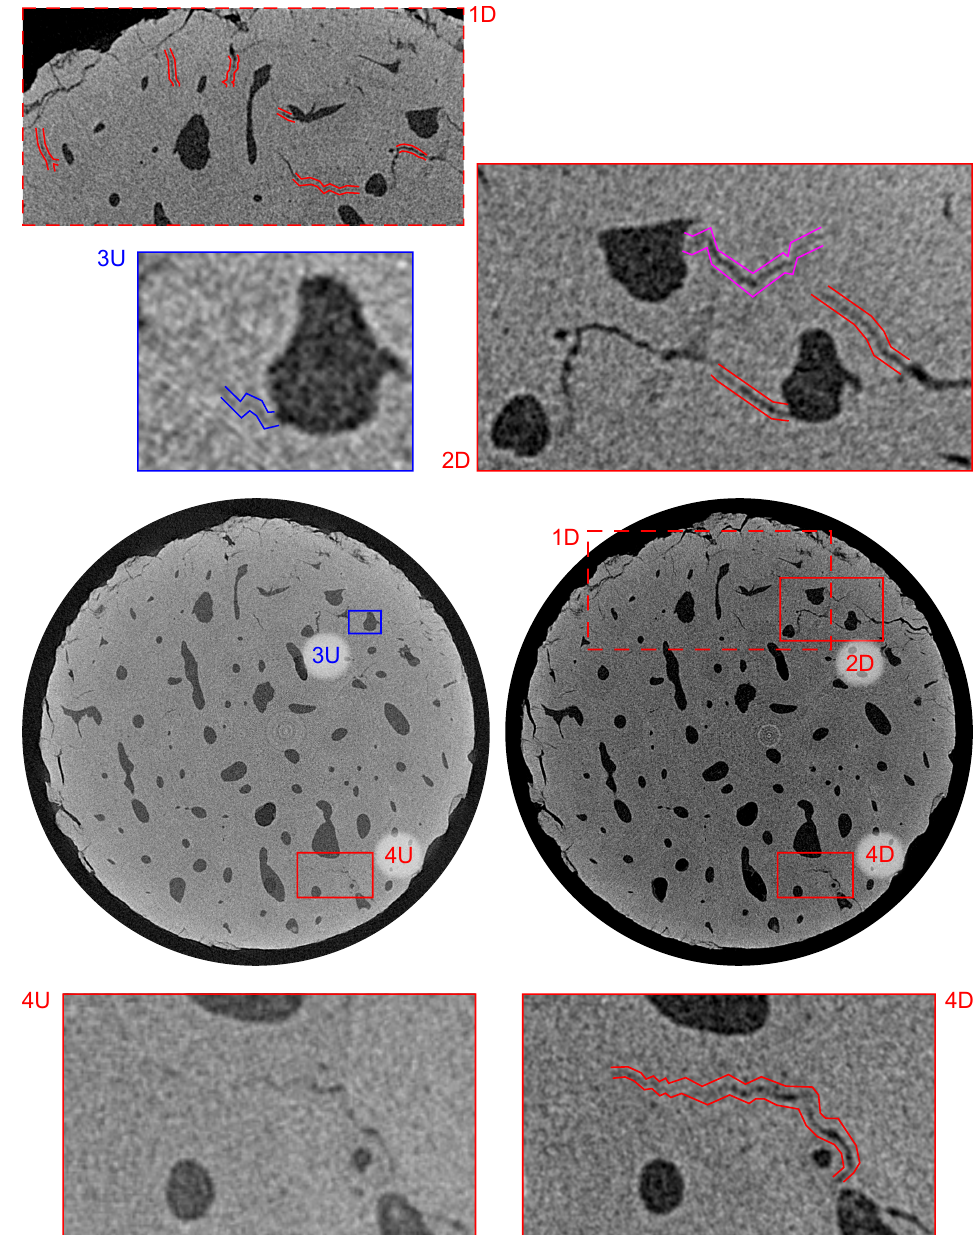
Figure 9. Visualization of the reconstructed 3D volumes—transverse plane at a distance of 2.64mm from the upper loading platen. Index “U” stands for intact (unloaded) state and “D” stands for loaded (damaged) state. Blue color depicts small microcrack present in the intact state, purple color depicts microcrack formed by the fatigue loading, and red color depicts microcracks with increased dimensions as a result of the loading